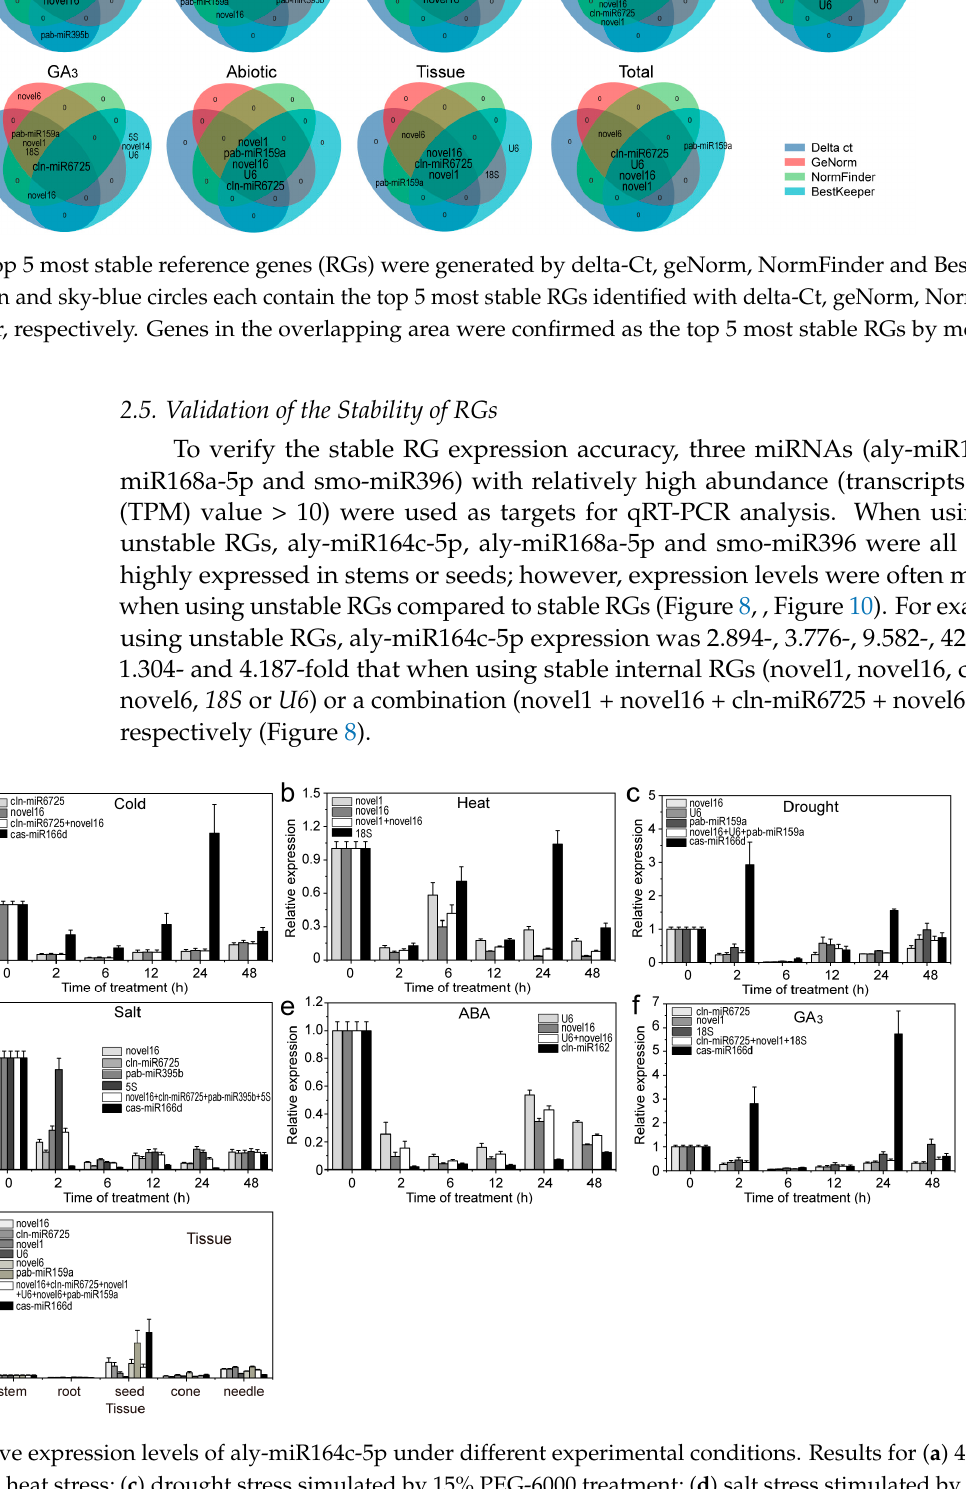
Figure 9. Relative expression levels of aly-miR168a-5p under different experimental conditions. Results from ( a ) 4 °C cold stress; ( b ) 40 °C heat stress; ( c ) drought stress simulated by 15% PEG-6000 treatment; ( d ) salt stress stimulated by 200 mM NaCl treatment; ( e ) 200 μ M ABA treatment; ( f ) 200 μ M GA 3 treatment; ( g ) different tissues (roots, stems, tender needles, cones and seeds). Error bars represent standard deviations (SD) (n = 3).